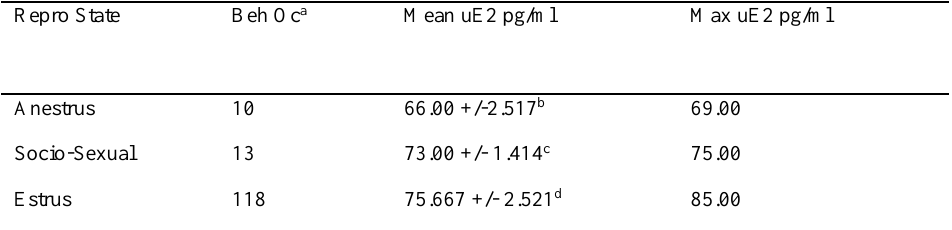
Animal 1 Number of Reproductive Behavioral Occurrences and uE2 Levels